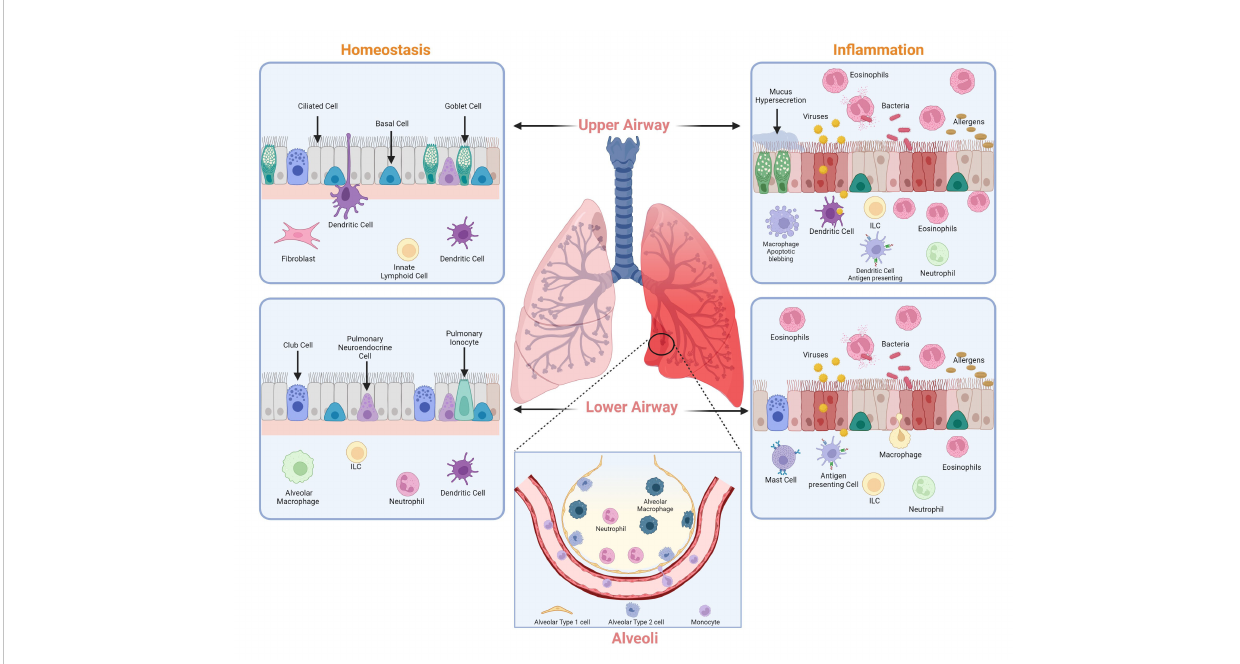
FIGURE 1 Major cell types of the lung. Cell types that contribute to the maintenance of lung homeostasis (left) and lung in fl ammation (right) in the upper and lower airways. Image created with